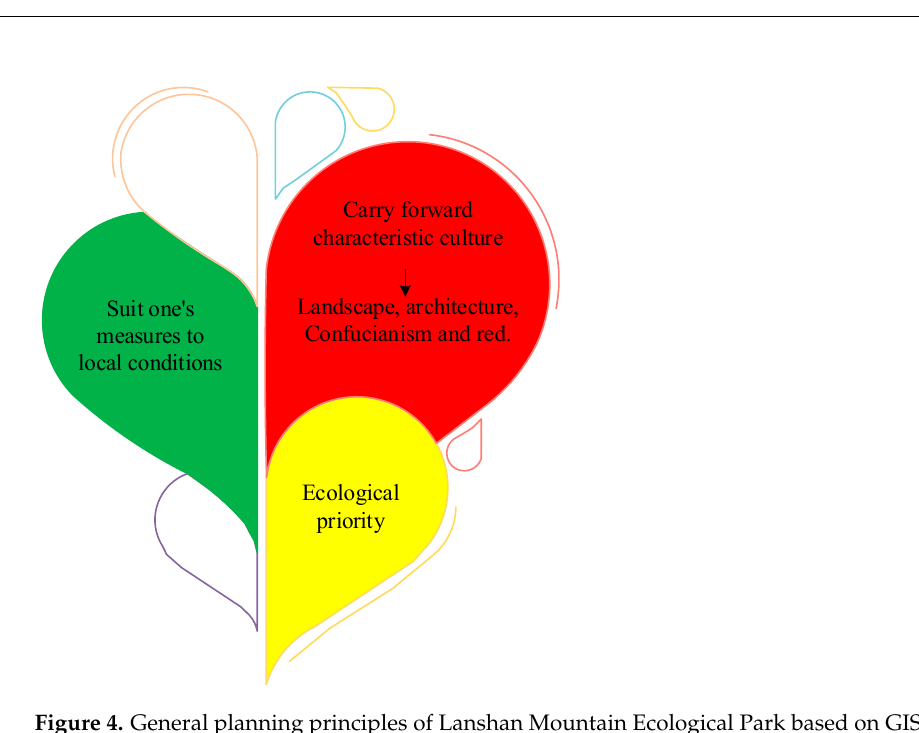
Figure 4. General planning principles of Lanshan Mountain Ecological Park based on GIS.